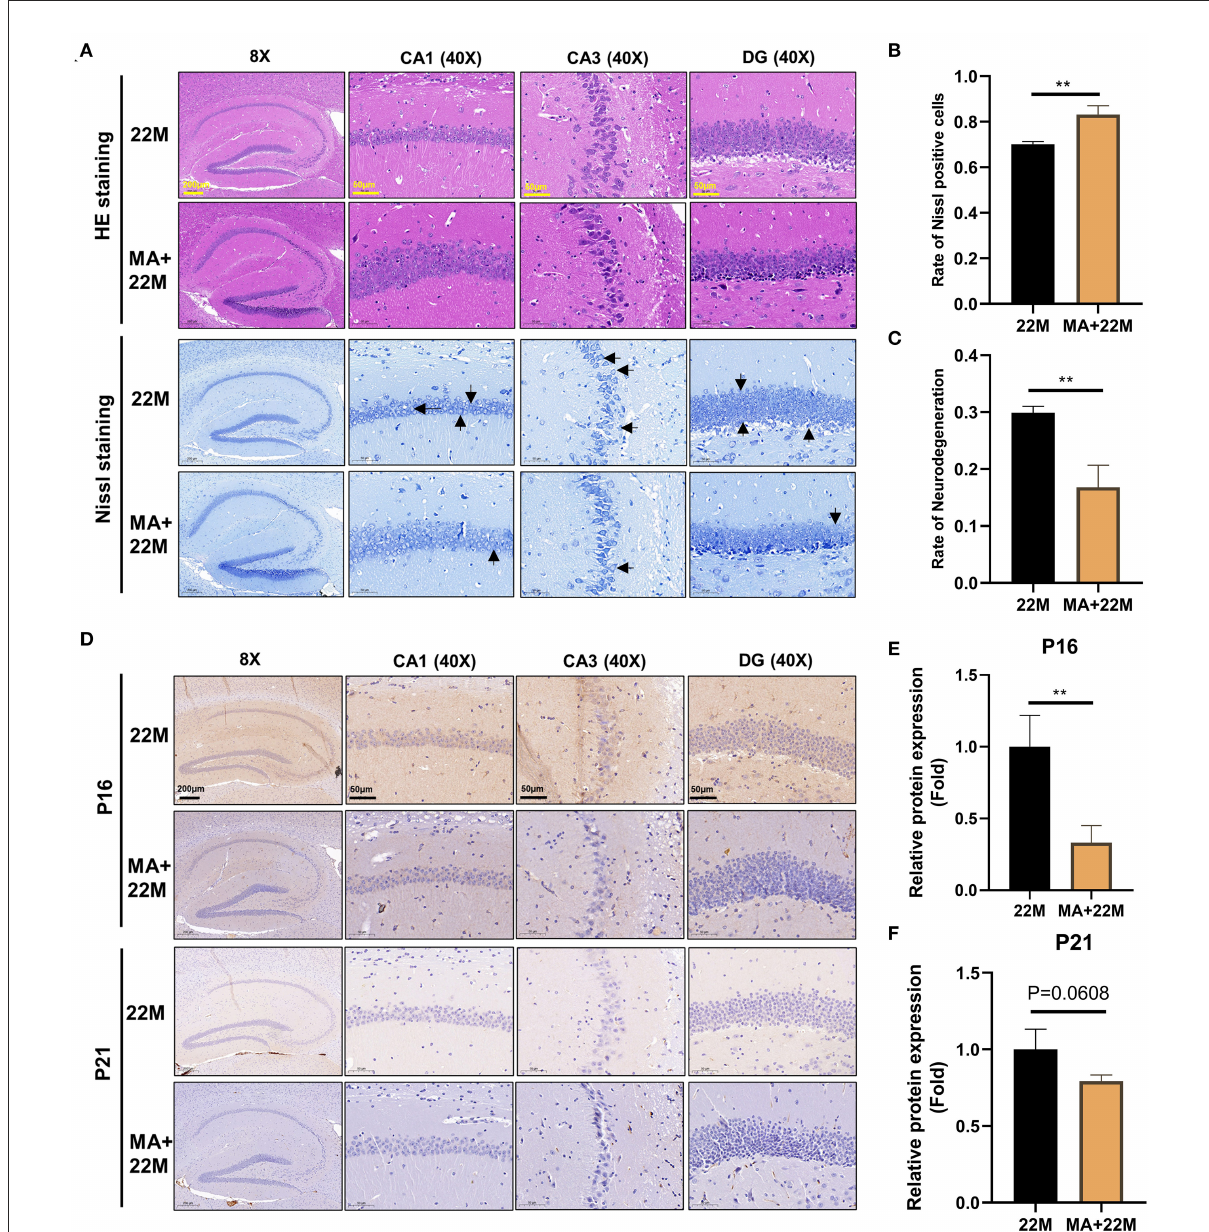
FIGURE6 Evaluation of hippocampal histomorphology in MA-treated aging mice. (A) H&E and Nissl staining in hippocampus between 22M and MA + 22M group. The magnifications and scale bars were shown in (A) . (B,C) Nissl positive cells and Neurodegeneration percentage in hippocampus were assessed by Nissl staining between 22M and MA + 22M group. Data were represented as mean ± SD and were analyzed by Student t -test. ** P < 0.01. Arrows showed degenerated neurons. (D) IHC of senescence markers P16 and P21 in the hippocampus between 22M and MA + 22M group. The magnifications and scale bars were shown in (D) . (E,F) Relative expressions of senescence markers P16 and P21 calculated by IHC. Data were represented as mean ± SD and were analyzed by Student t -test. ** P <